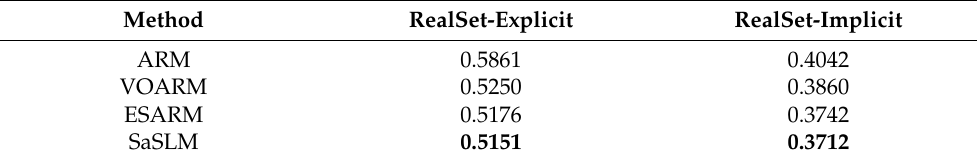
Table 3. Fitting set ratings using different